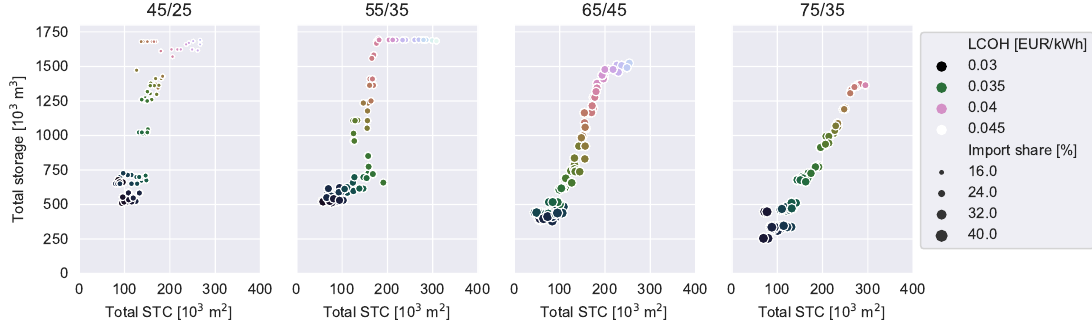
Figure 18. Correlation plot between total TES volume and STC area for GenkNet for different network temperatures. All plots have a fixed excess heat cost of